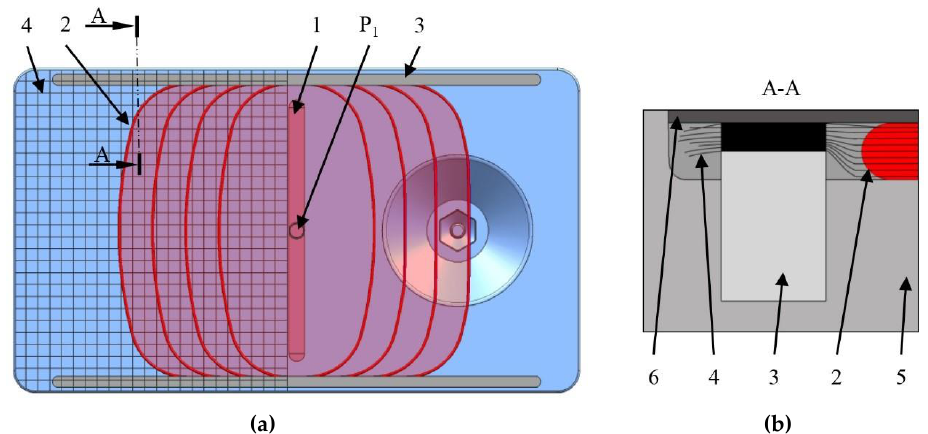
Figure 8. Layout of the mold cavity with the reinforcement inside ( a ) (P 1 —first inlet point; 1—flow leader groove; 2—flow front distribution in the cavity; 3—textile fixer; 4—textile; ( b ) cross-section of the textile fixer (5—the upper half of the T-RTM mold; 6—the bottom half of the T-RTM mold).